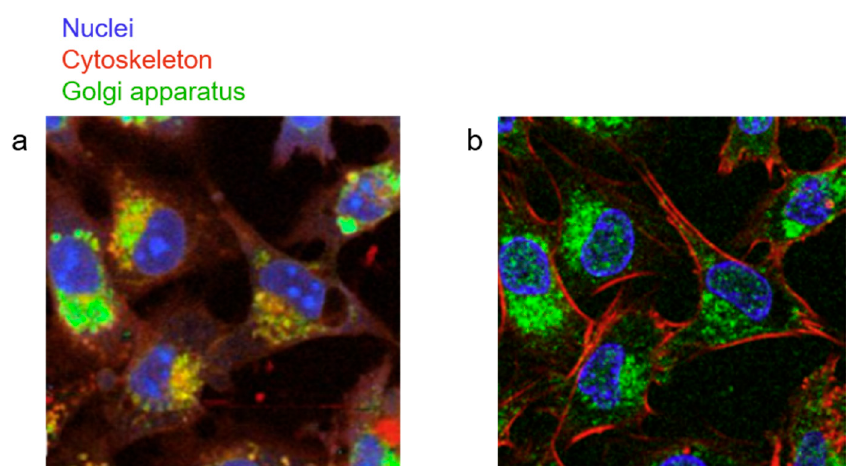
Figure 2. Comparison of Raman-based, artificial IF and fluorescence imaging. ( a ) A Raman-based, artificial IF image of cultured human glioma cells with false color assignments showing the nuclei in blue, cytoskeleton in red, and Golgi apparatus in green. ( b ) An immunofluorescent image of the same cells staining the nuclei (DAPI, blue), cytoskeleton (rhodamine-conjugated phalloidin, red), and Golgi apparatus (anti-Syntaxin-6-antibody, green). Reproduced with permission from [63], Copyright Elsevier, 2012.